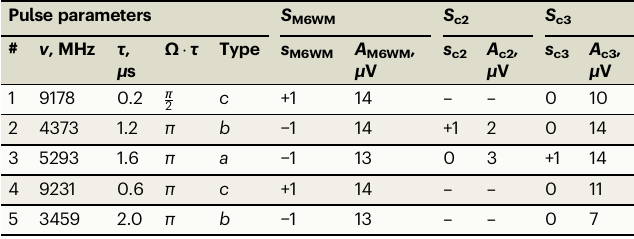
Table 1 | Pulse sequence parameters and the fi t results of phase scans Pulse